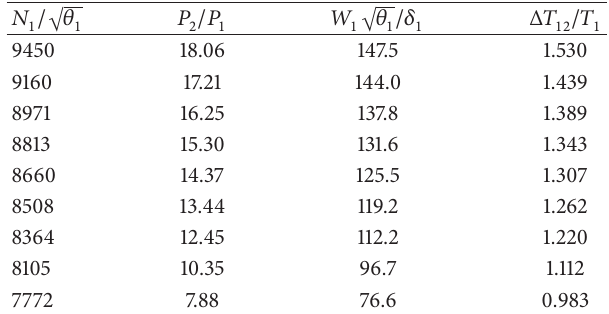
Figure 10: The efficiency curve in design and fouled condition when operating time is 400 hours. Table 4: LM2500-30 compressor design parameter. Parameter